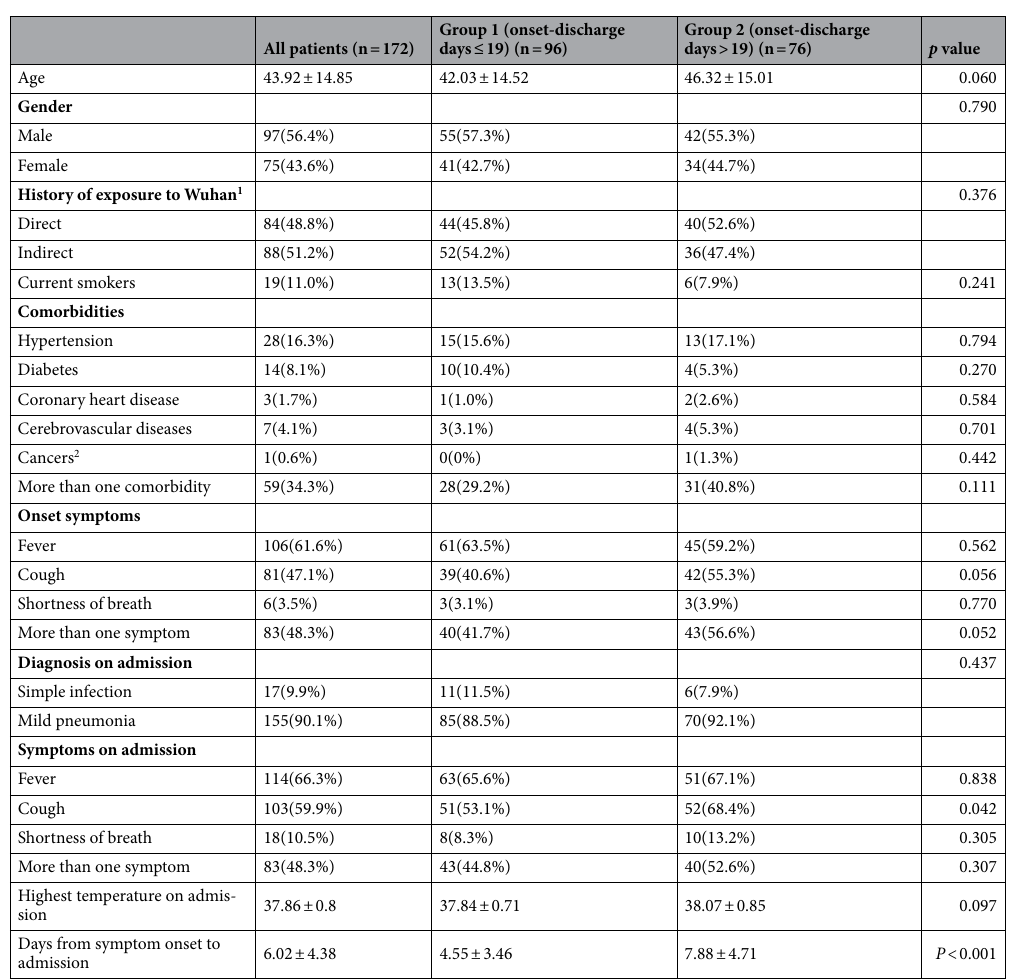
2 Cancers referred to any malignancy. All cases were stable disease. P values denoted the comparison between Group 1 and Group